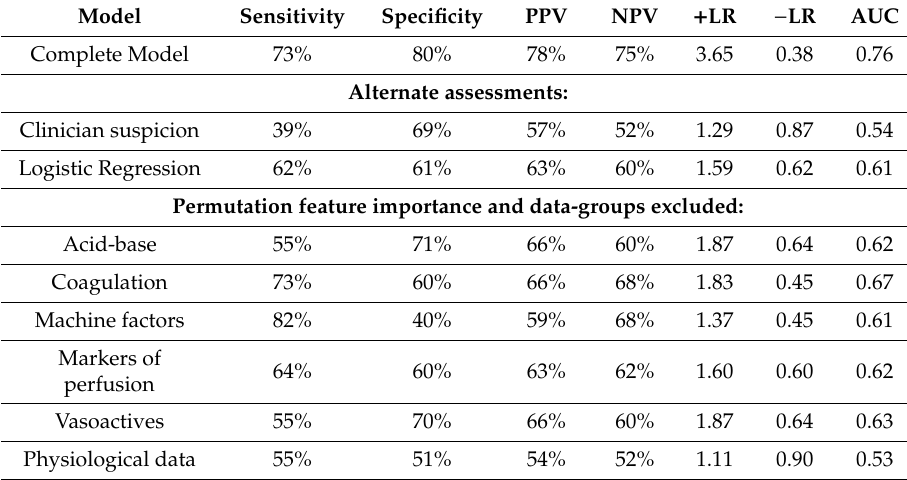
Table A3. Detailed statistical results of all assessed models in